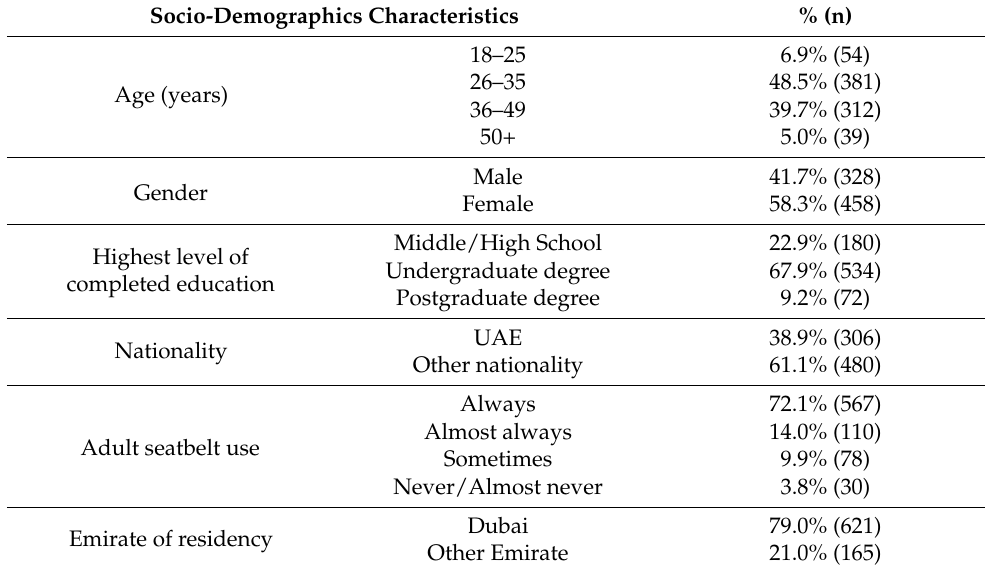
Table 1. Participants’ socio-demographics characteristics and restraint